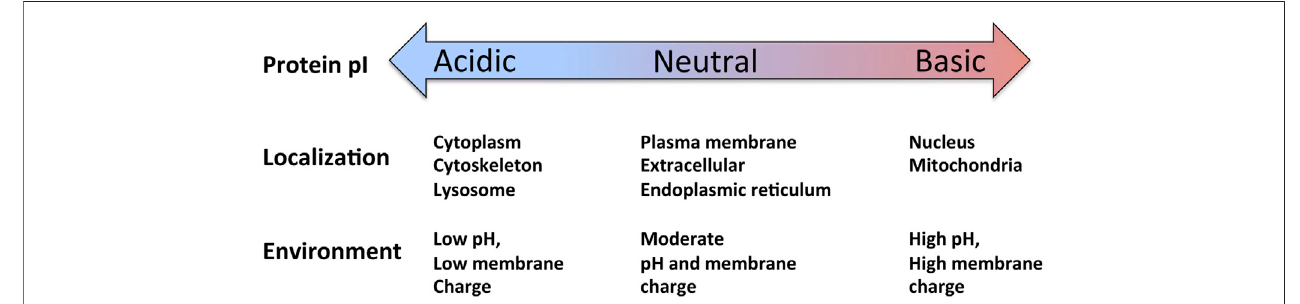
FIGURE 2| Relationships between protein pI and subcellular localization in the human proteome (see text for detailed explanations). Figure adapted from Kurotani et al., 2019 (CC BY 4 license, authors retain the